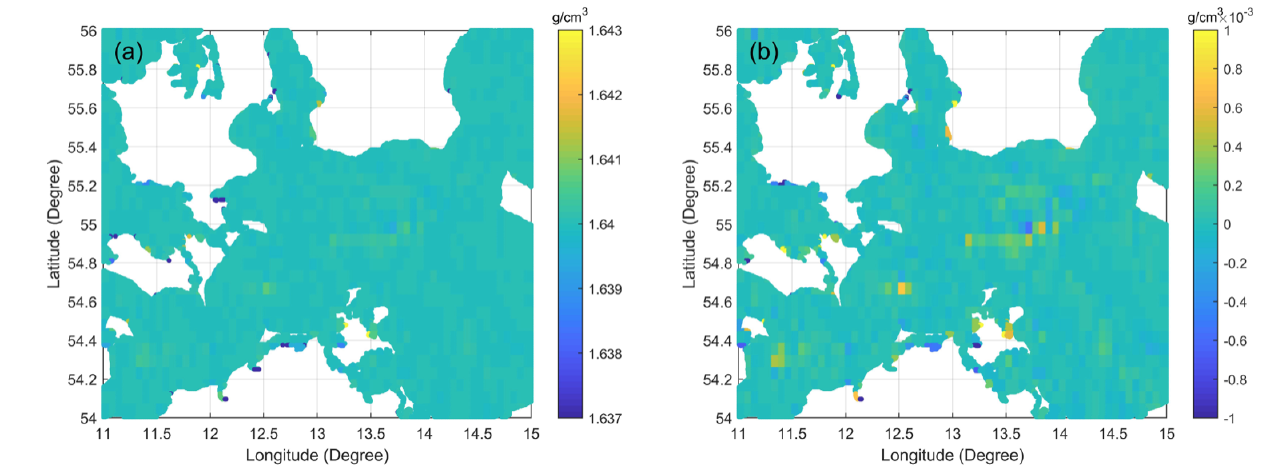
Figure 8. The determined ∆ ρ ( a ) and the corresponding error ( b